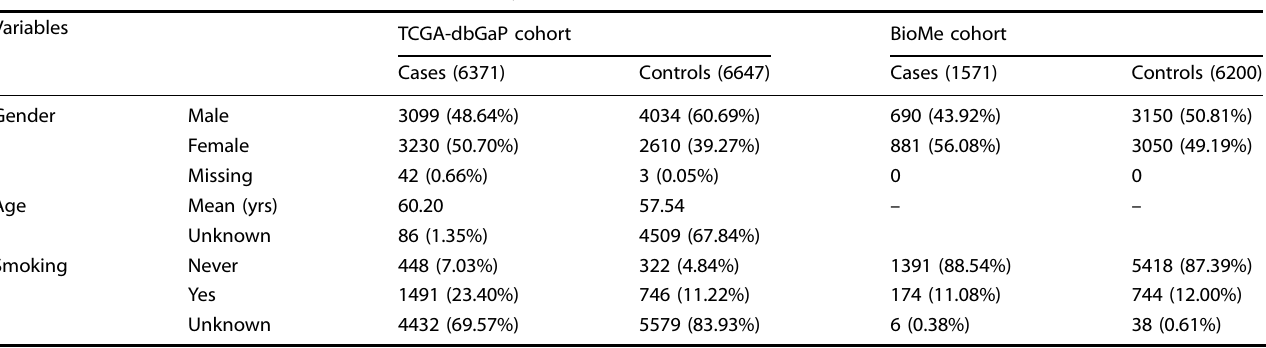
Table 1. Characteristics of samples in the case-control study